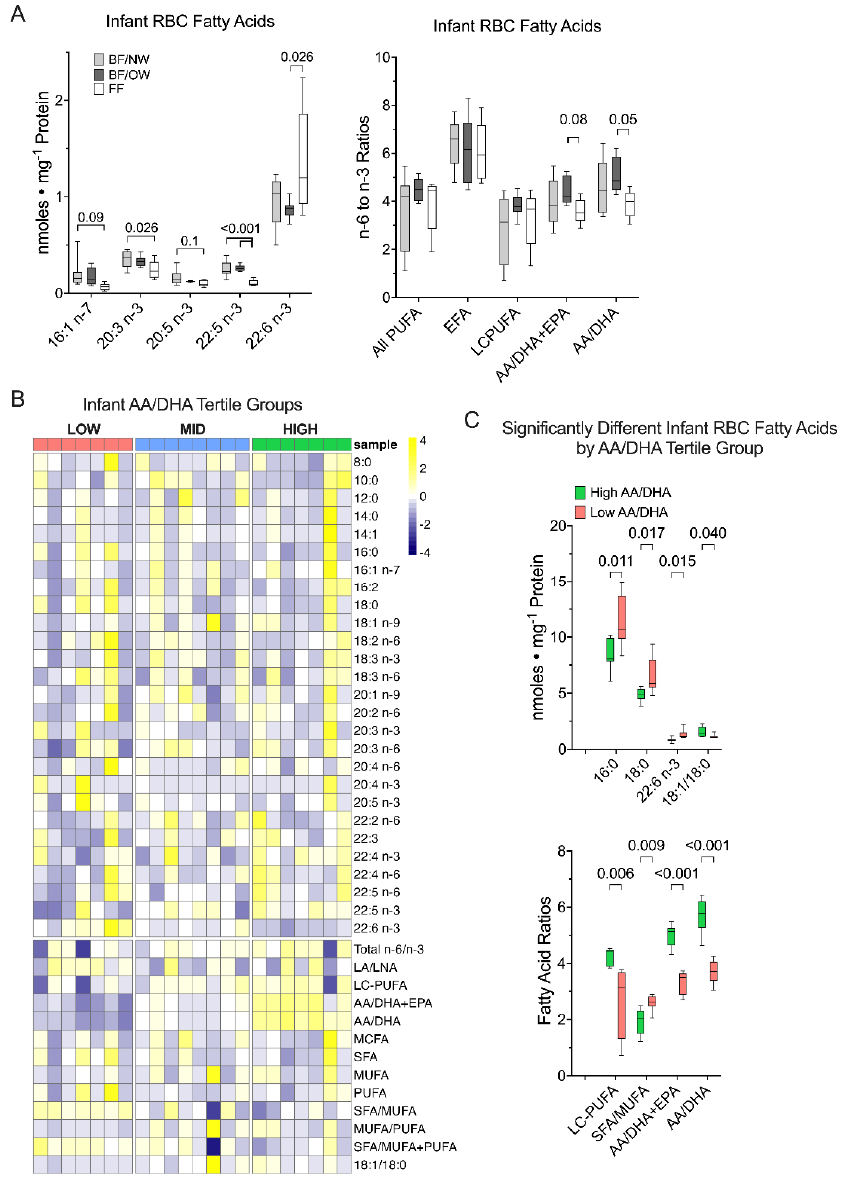
Figure 1. Red blood cell (RBC) fatty acid composition among breastfed and formula-fed infants. ( A ) Infants were grouped by feeding type. In the formula-fed infant group, only docosahexaenoic acid (DHA) was increased, while other key n3 LC-PUFA were decreased or tended to be decreased. Infant RBC total fatty acid levels of arachidonic to docosahexaenoic acid ratio (AA/DHA) were significantly lower in FF relative to the BF/OW infant group ( p = 0.05 by 1-way ANOVA). ( B ) Heatmap projection of the infant RBC fatty acid composition for each acyl chain length and saturation, indicating a high degree of variance among fatty acids, their quantitative sums, and ratios, when grouped by the RBC total fatty acid AA/DHA ratio. ( C ) Significantly different individual fatty acids or their quantitative ratios when grouped by infant RBC total fatty acid AA/DHA ratio. (BF/NW = breastfed infants/normal weight mothers, BF/OW = breastfed infants/overweight mothers, FF = predom- inantly formula-fed infants; n = 8, 9, and 5, respectively; EPA = 20:5 n3, eicosapentaenoic acid; LC-PUFA = long-chain polyunsaturated fatty acids; SFA/MUFA = saturated to monounsaturated fatty acid ratio; AA/DHA + EPA = 20:4 n6/22:6 + 20:5 n3 arachidonic to docosahexaenoic plus eicosapentaenoic acid ratio; AA/DHA = 20:4 n6/22:6 n3 arachidonic to docosahexaenoic acid